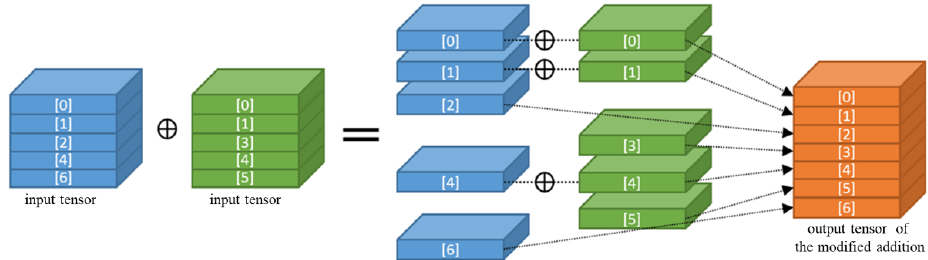
Figure 8. Slice and concatenation.